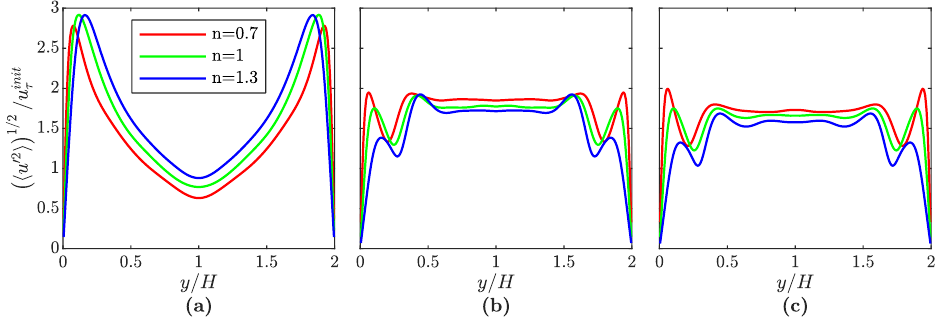
Figure 9. Root mean square of the stream-wise velocity fluctuations u (cid:48) , normalized by the friction velocity of the initialization setup, as a function of the wall-normal coordinate for the single-phase ( a ) and the two-phase setups with Eo = 0.3125 ( b ) and Eo = 3.75 ( c